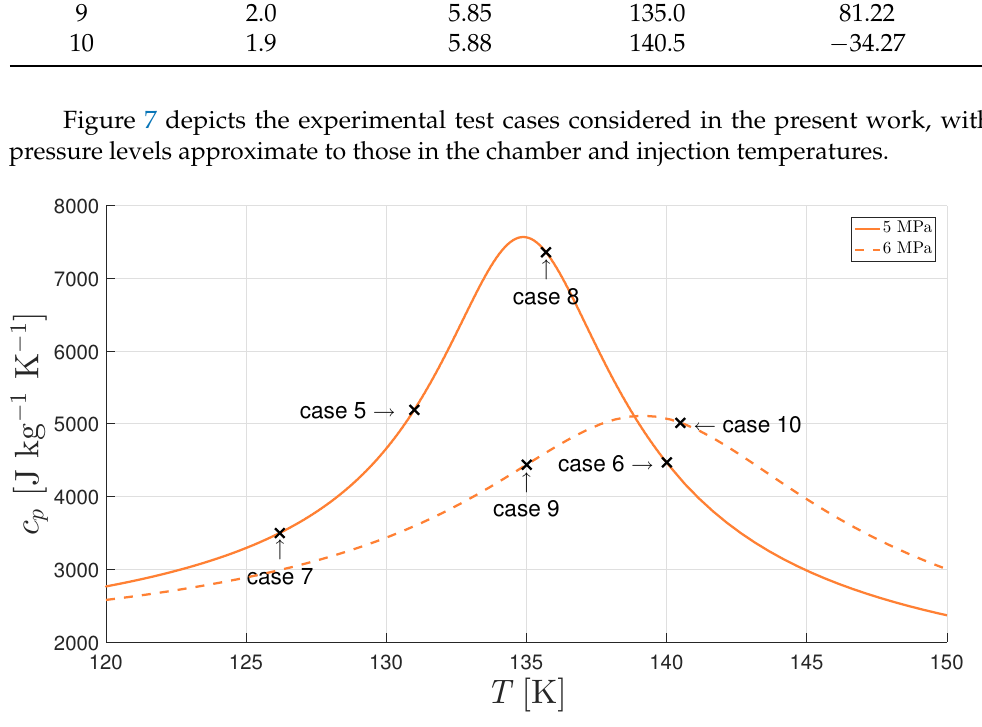
Figure 7. Description of the experimental test cases and chamber conditions, concerning the maxi- mum in isobaric specific heat, for pressure levels of 5 and 6 MPa and injection